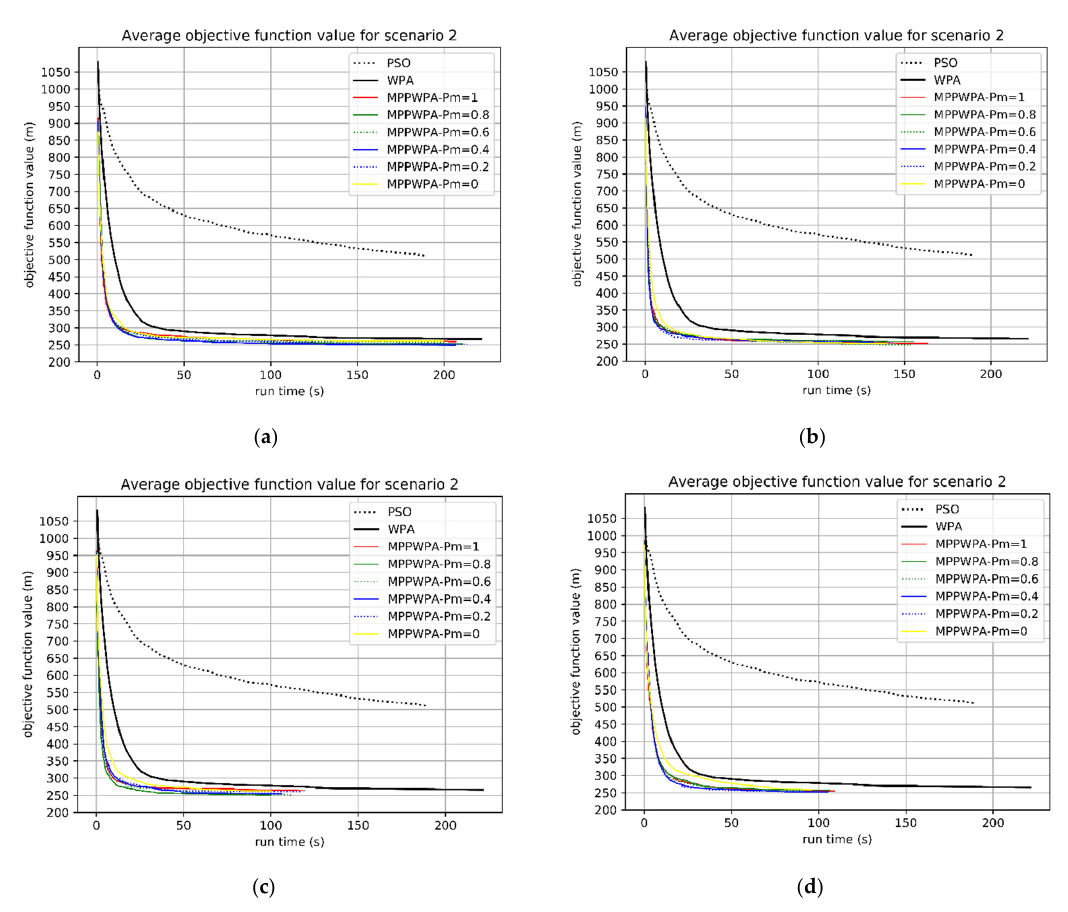
Figure 19. Average objective function values with different 𝑁𝑢𝑚 and 𝑃 (cid:3040) in scenario 2: ( a ) 𝑁𝑢𝑚 = 2 ; ( b ) 𝑁𝑢𝑚 = 4 ; ( c ) 𝑁𝑢𝑚 = 8 ; ( d ) 𝑁𝑢𝑚 = 16 . Table 8. Objective function value with different 𝑃 (cid:3040) in scenario 2.